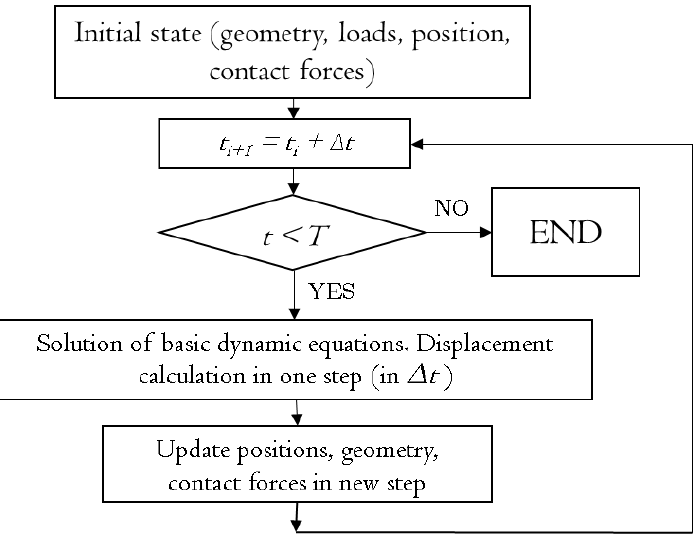
Figure 4. Simulation cycle of the Discrete Element Method [41].